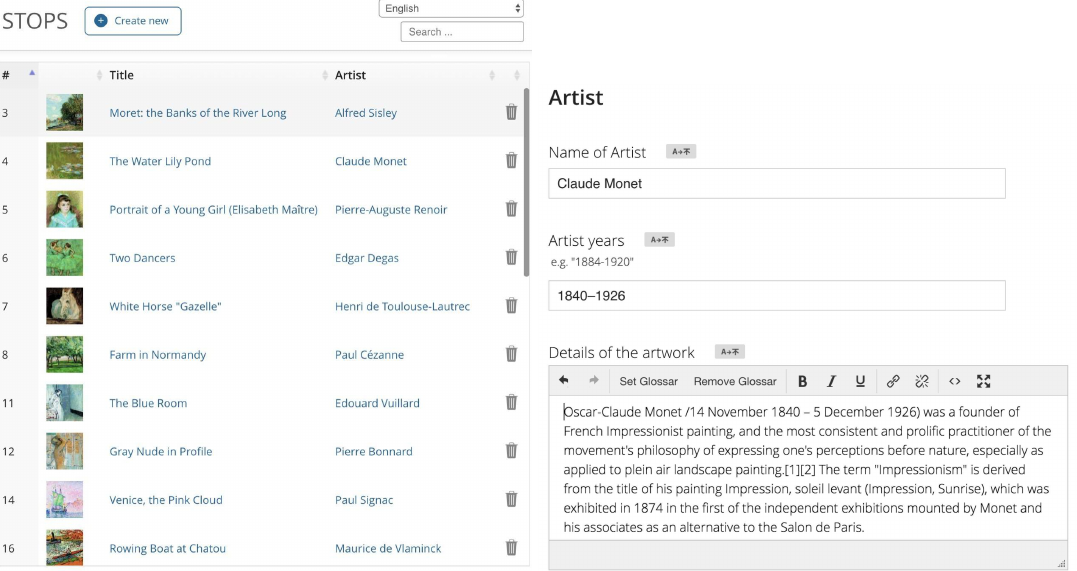
Figure 11. CMS: Exhibit-content and